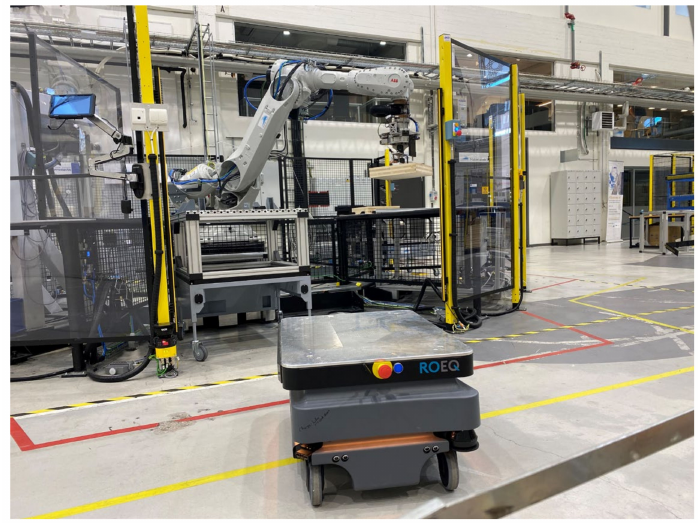
Figure 8. This figure shows the physical Plug and Produce cell, including the AMR, which is used in the demonstrator.